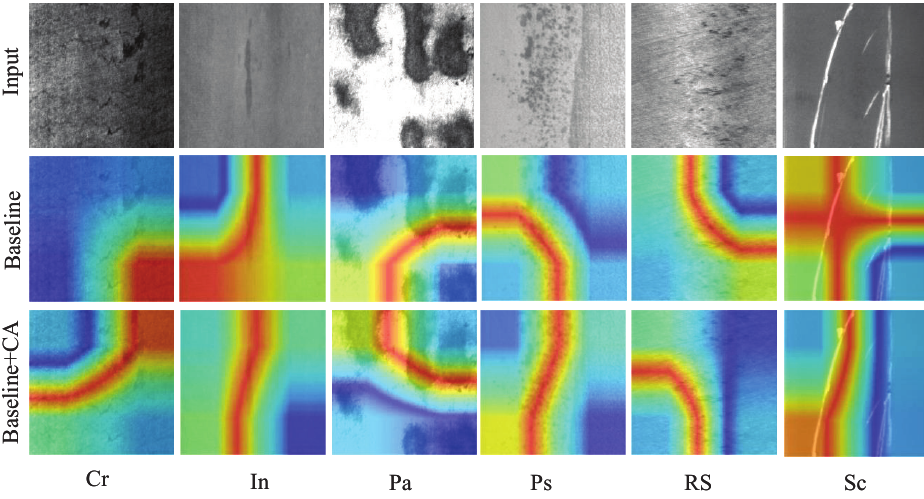
Figure 8. Comparison of the heat map visualization results before and after embedding Coordinate